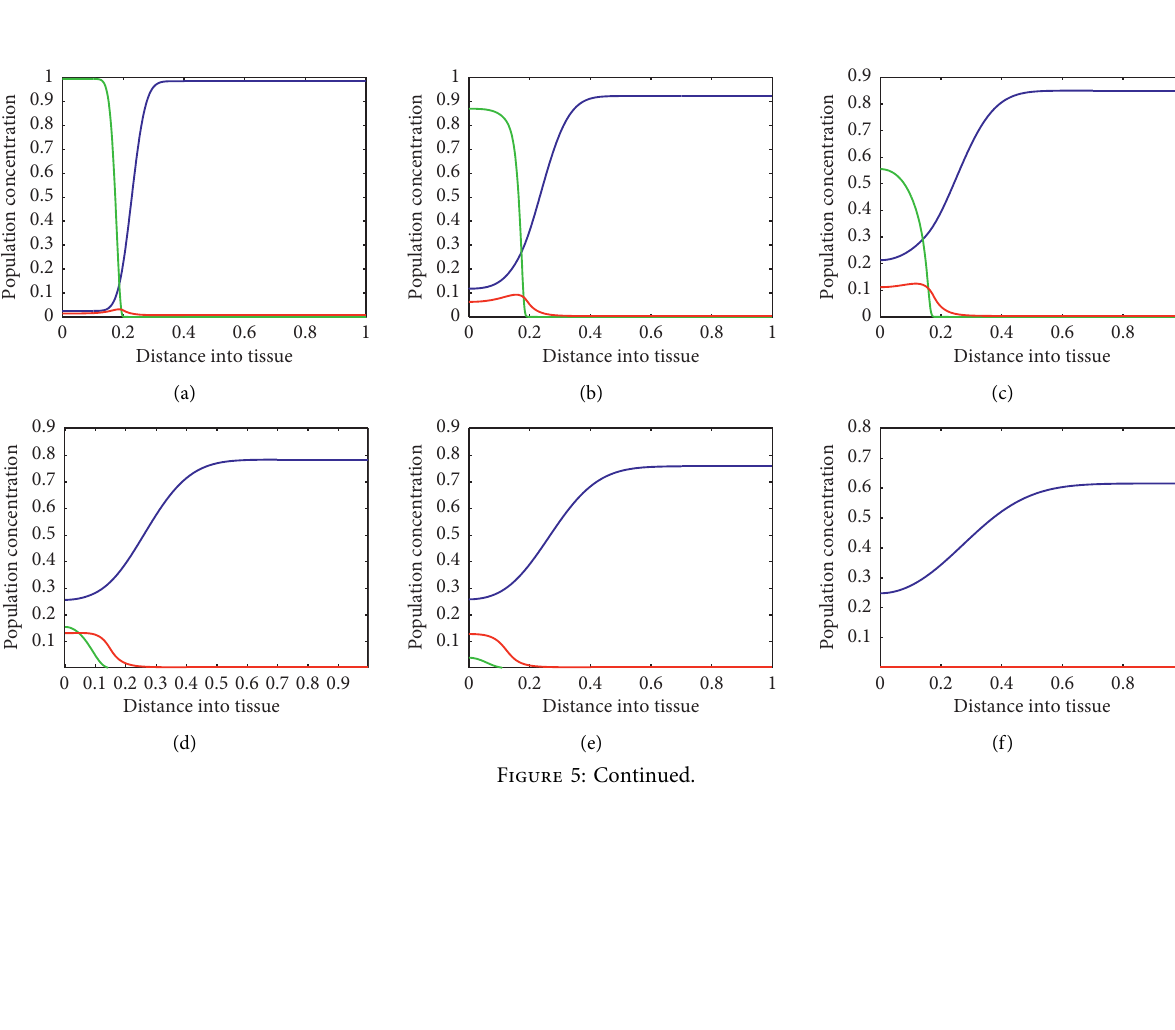
Figure 4: The trajectory and the limit cycle of system (3).